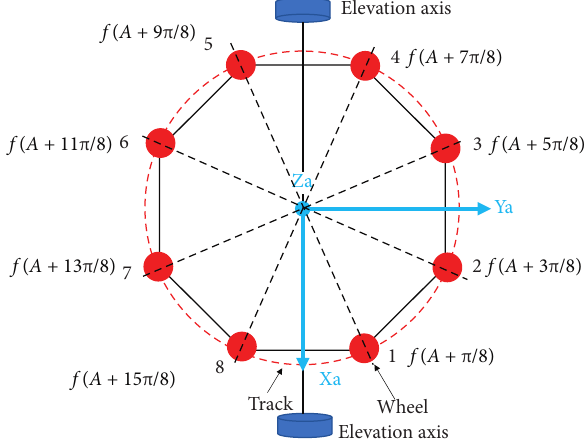
Figure 6: The sketch of the eight-support-point telescope design.